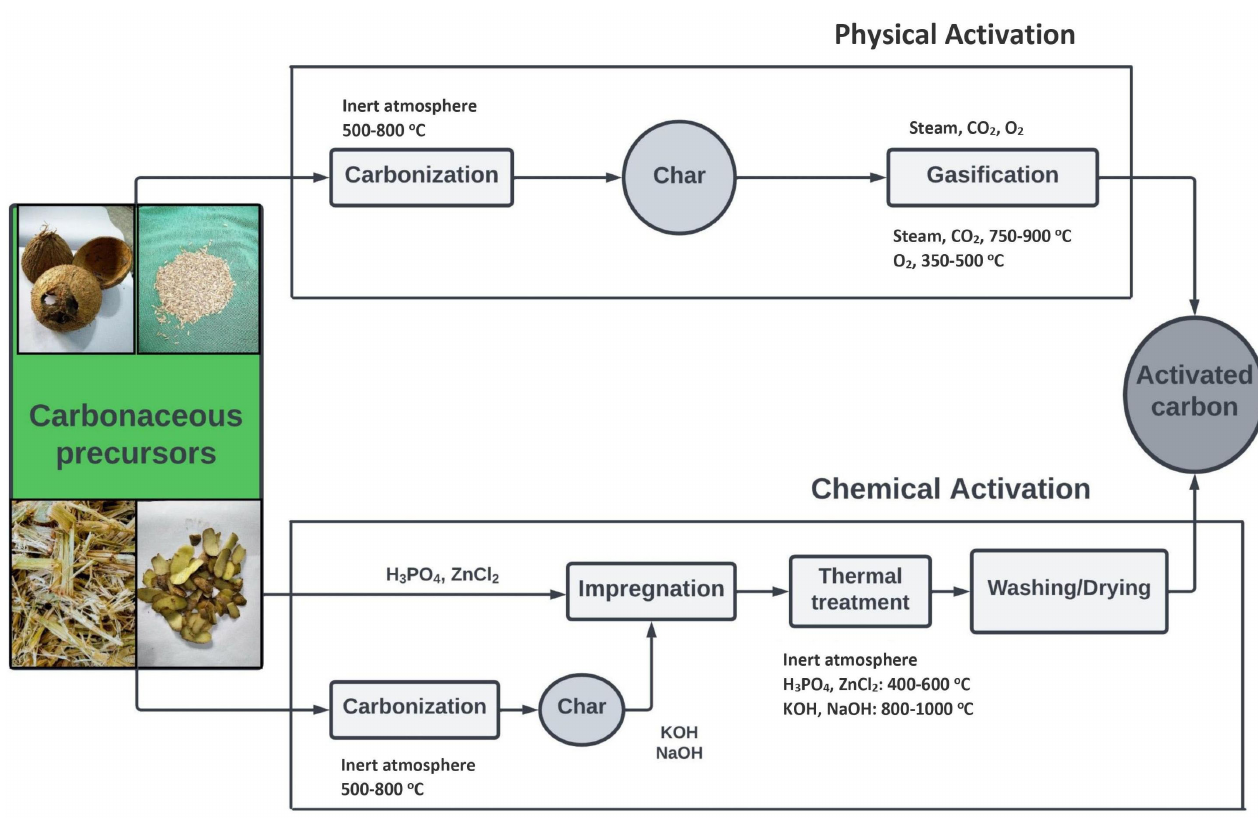
Figure 8. Physical activation and chemical activation flow chart [181].